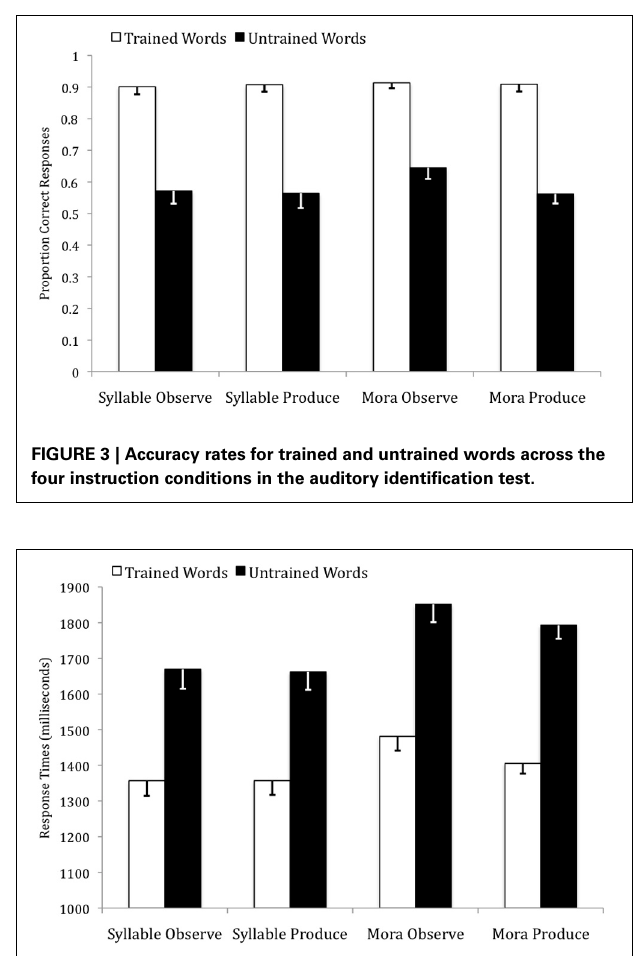
FIGURE 4 | Response times for trained and untrained words across the four instruction conditions in the auditory identification test.